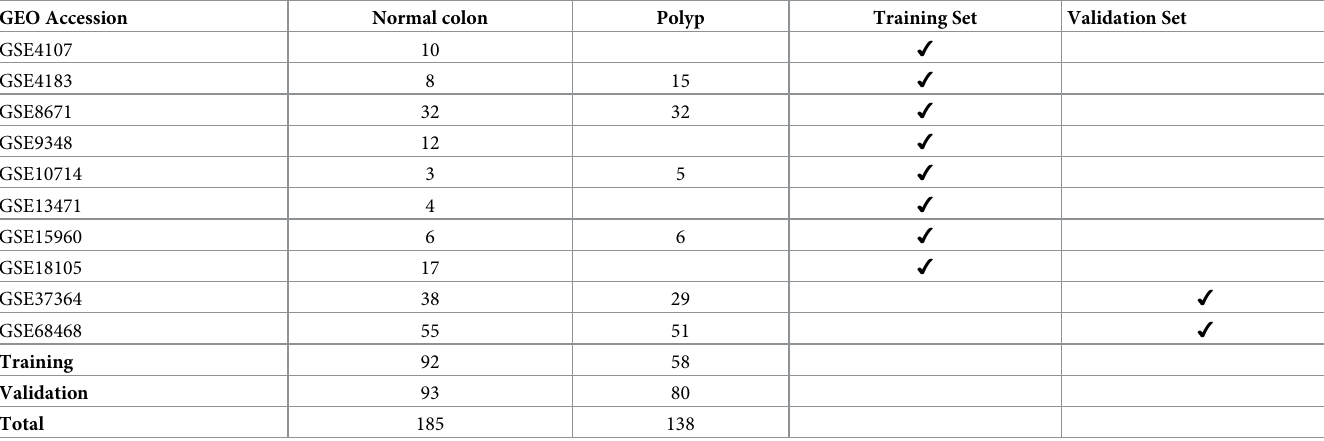
Table 1. Datasets used in the